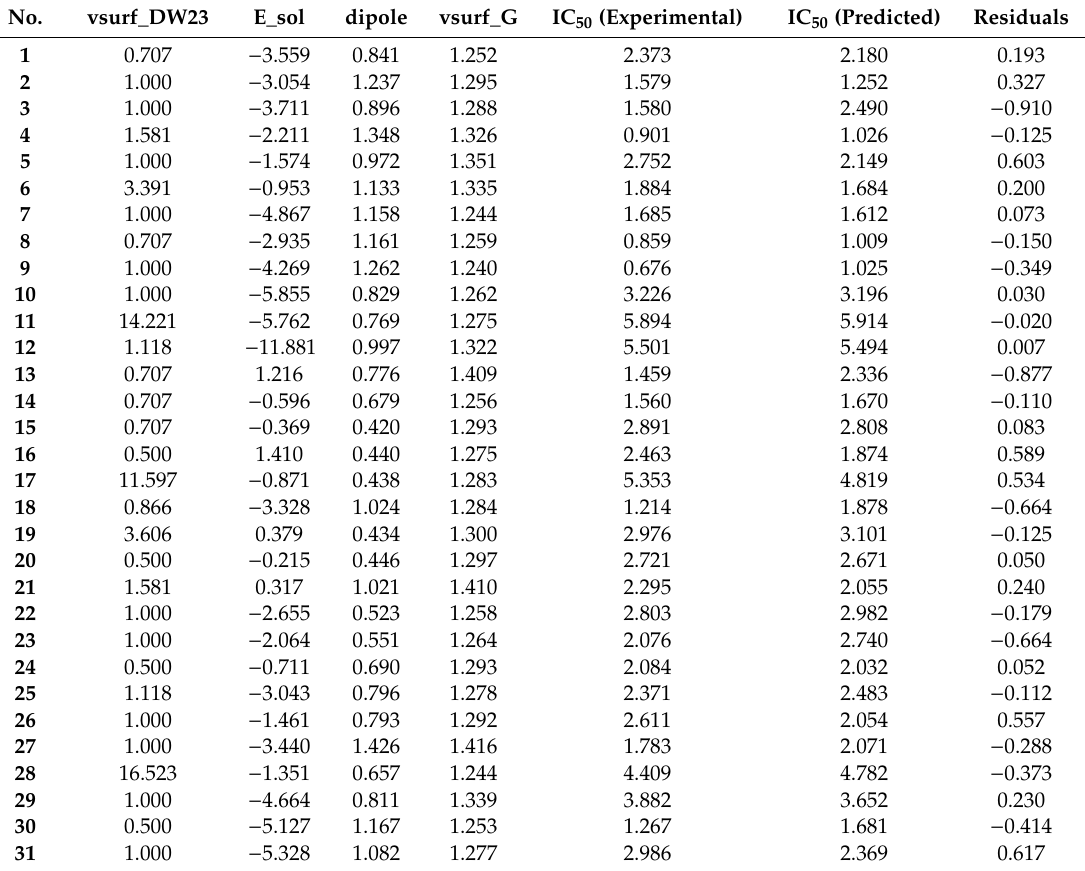
Table 4. Calculated results using the quantitative structure–activity relationship (QSAR)